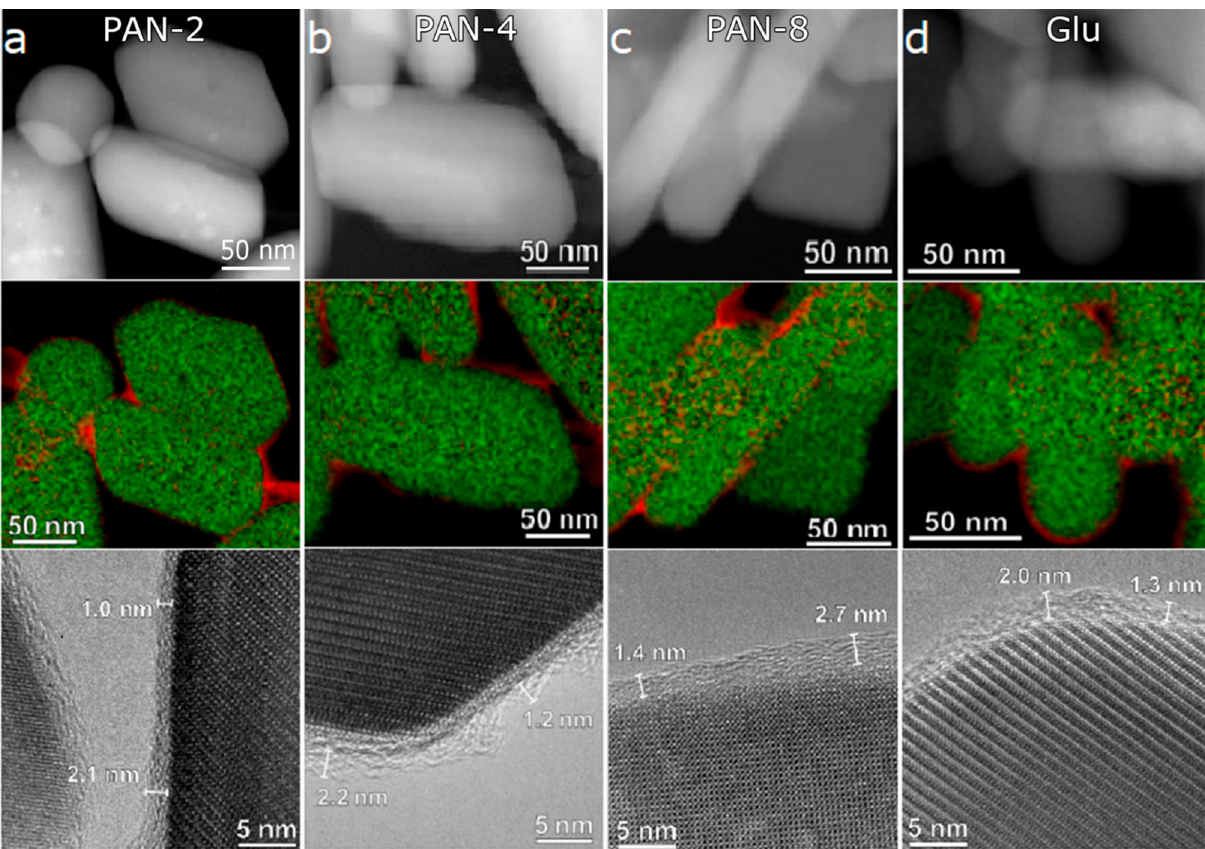
Figure 3. DF-STEM images and colored STEM-EELS maps of PAN-2 ( a ), PAN-4 ( b ), PAN-8 ( c ), and Glu ( d ); red color represents the EELS signal from carbon layer, while green color is overall inorganic signal from the sample.